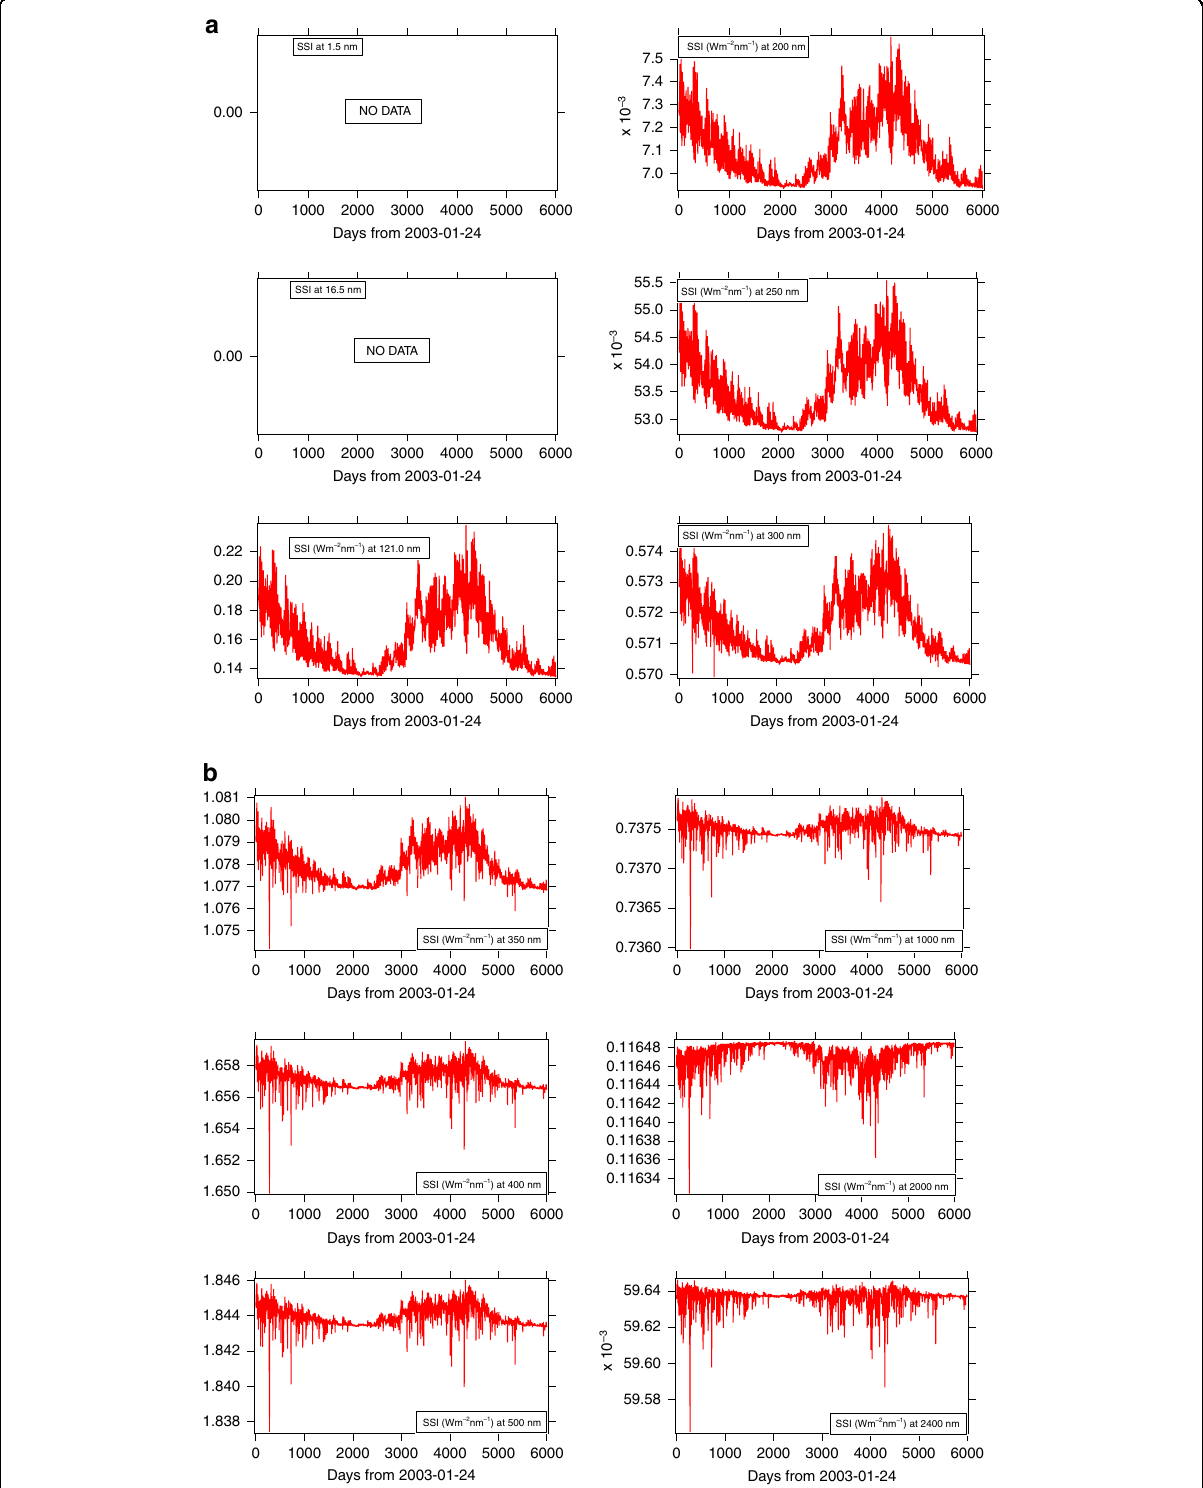
Fig. 3 Modeled time series by using SATIRE. a For 10 wavelengths from EUV to IR, 121.0 – 300 nm. b For 10 wavelengths from 350 – 2400